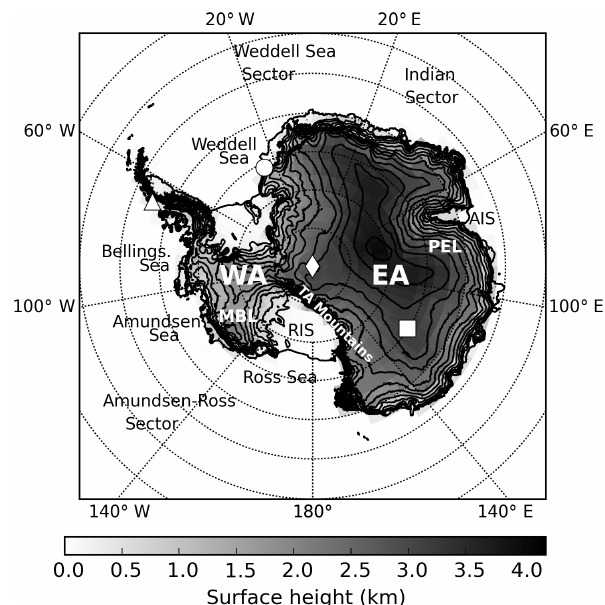
Figure 1. The Antarctic continent (Antarctica) and its topography (Fretwell et al., 2013), along with names of places mentioned in this study. The Transantarctic (TA) Mountains separate West Antarc- tica (WA) from East Antarctica (EA). Two ice shelves are also re- ported: the Ross Ice Shelf (RIS) and the Amery Ice Shelf (AIS). MBL stands for Marie Byrd Land and PEL for Princess Elisabeth Land. Bellings. refers to Bellingshausen. The location of two UK, one French–Italian and one US Antarctic stations are indicated with markers: Rothera (triangle), Halley VI (circle), Concordia (square) and Amundsen–Scott South Pole Station (diamond shape). Mea- surements made at these stations are used in Sect.